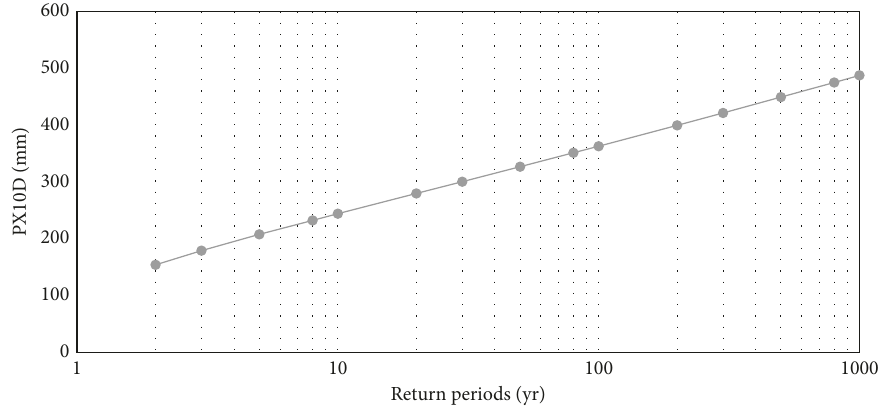
Figure 11: Frequency curve of PX10D in Shangqiu